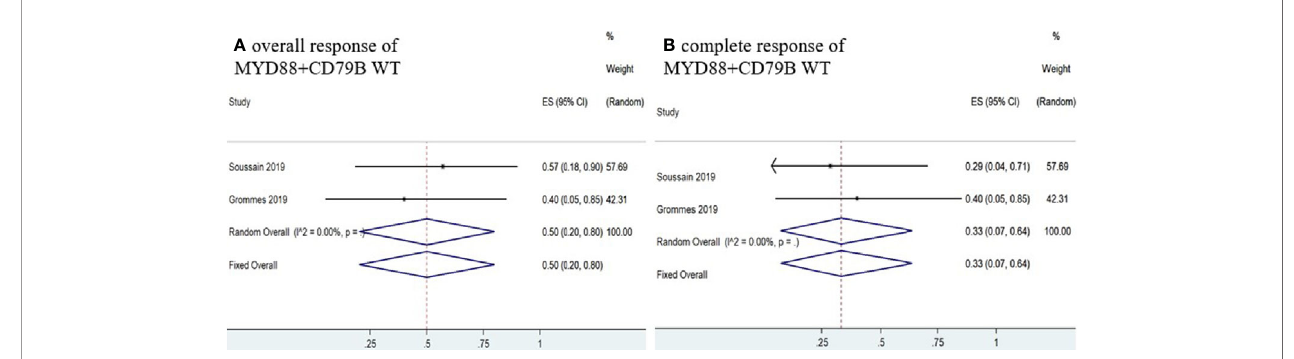
FIGURE 9 | Pooled response rate for MYD88 and CD79B wild-type gene status. (A) Pooled overall response of MYD88 and CD79B wild-type. (B) Pooled complete response of MYD88 and